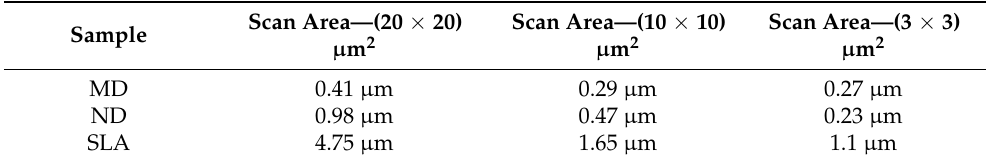
Table 1. The comparison of average roughness of ND, MD, and SLA surfaces measured via intermittent-contact AFM. The roughness depends on the scan area. For ND titanium surfaces and for large scan frame sizes, the roughness was determined by large-scale hills and valleys, whereas roughness for smaller scan areas was mainly due to the height of the titanium spikes.